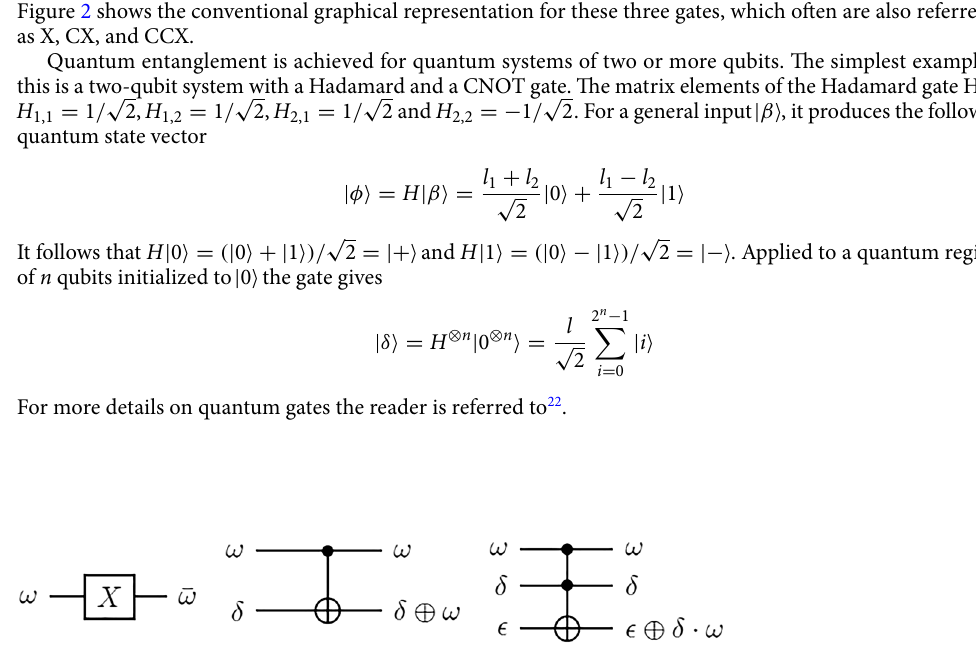
Figure 2. ( a ) NOT , ( b ) CNOT, ( c ) CCNOT. A bar indicates negation. A